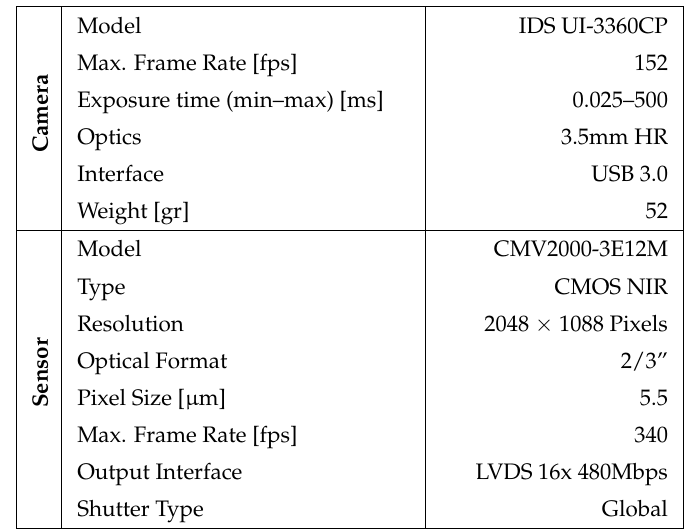
Table 1. Camera and sensor